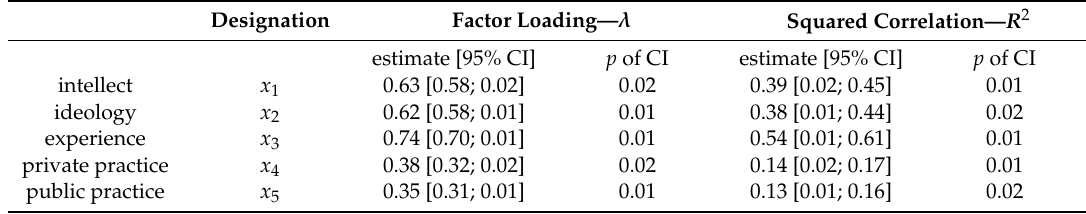
Table A6. Results of the Confirmatory Factor Analysis of the